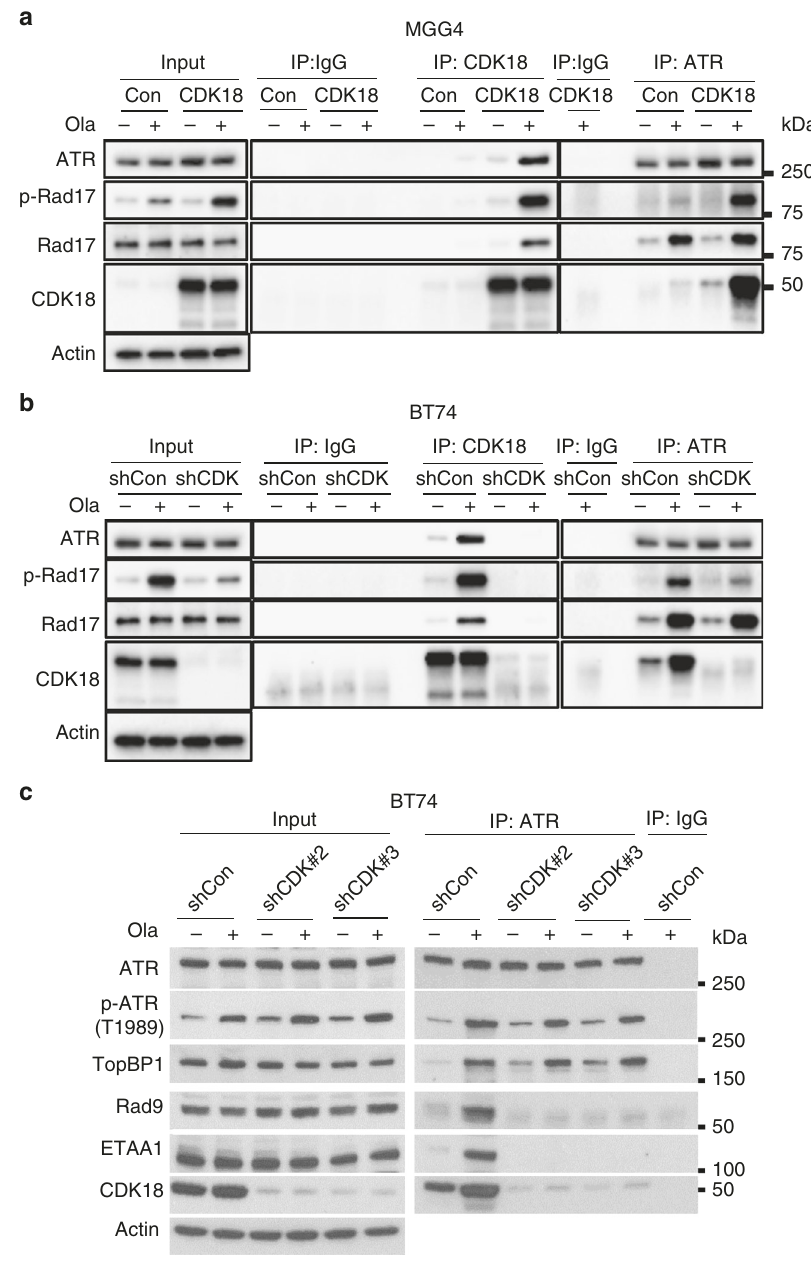
Fig. 6 Cyclin-dependent kinase 18 (CDK18) interacts with ATR and regulates ATR – Rad9 and ATR – ETAA1 interactions. Immunoprecipitation (IP) with antibodies to IgG (control), CDK18, and ATR. a MGG4 with CDK18 or without (Con) and b , c BT74 with CDK18 knockdown (shCDK18 #2 or as indicated) or not (shCon), treated with Ola ( + ; 10 μ M) or mock ( − ) for 24 h. Doxycycline initiated 6 days before olaparib treatment. β -Actin was the loading control. Proteins are listed on the left, molecular weight markers are indicated to the